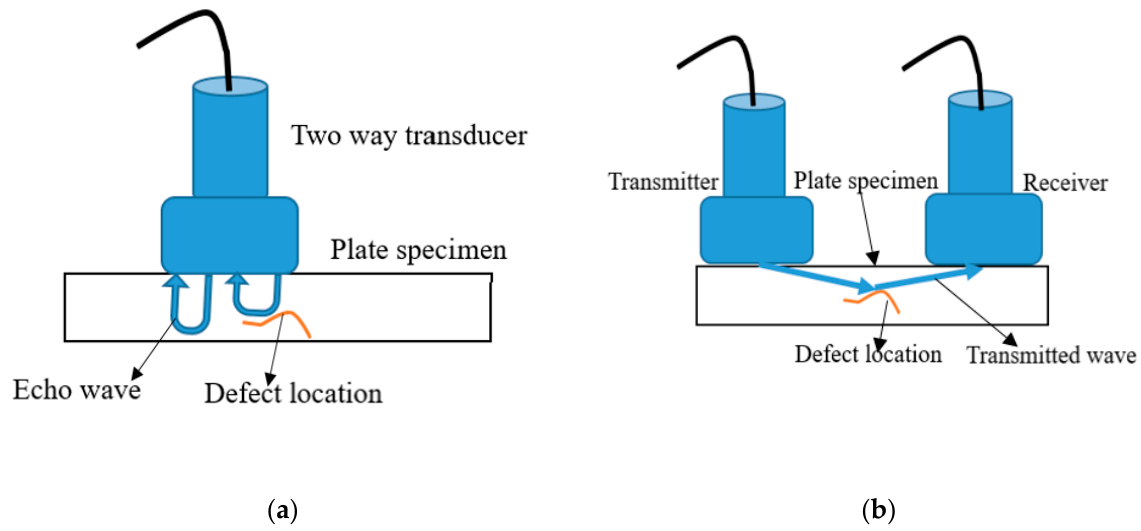
Figure 4. ( a ) Pulse–-echo method with a transducer; ( b ) Pitch–catch method with two t ransducers(R) [86].